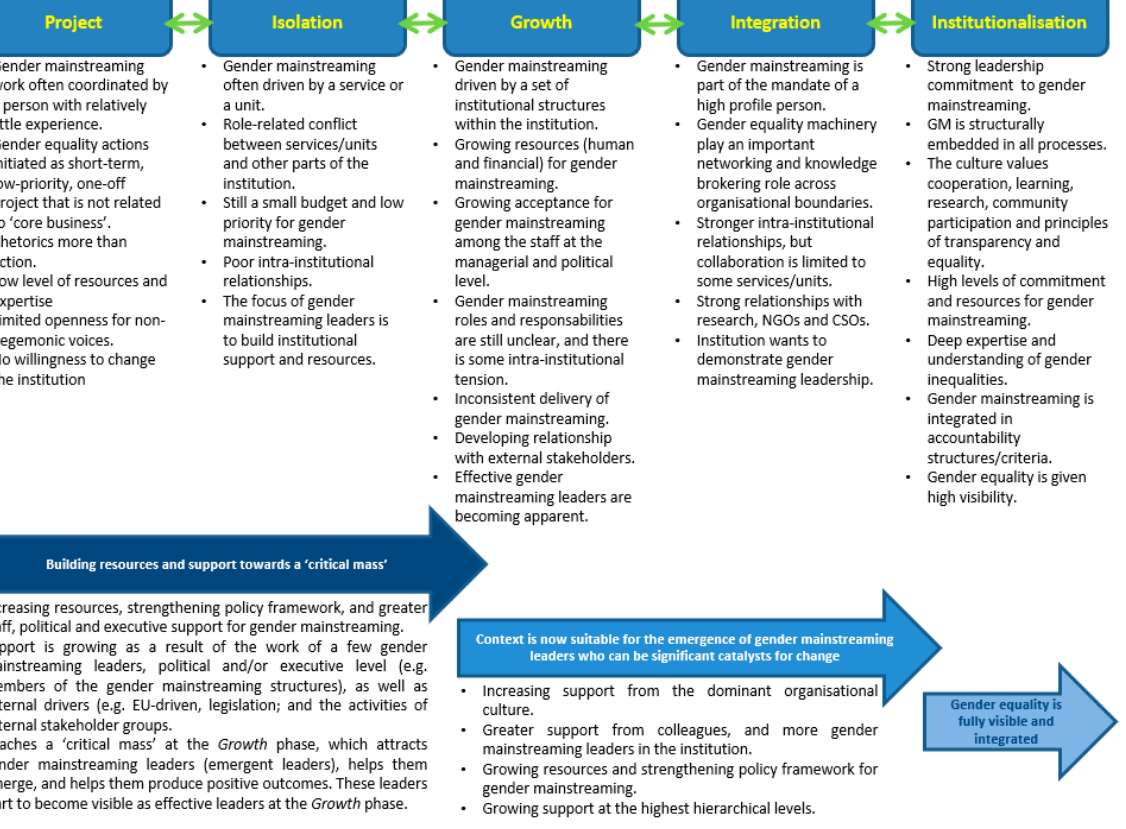
Figure 2. Stages of institutional development of capacity for gender mainstreaming, based on Taylor 2010 (Mergaert and Wuiame 2013).